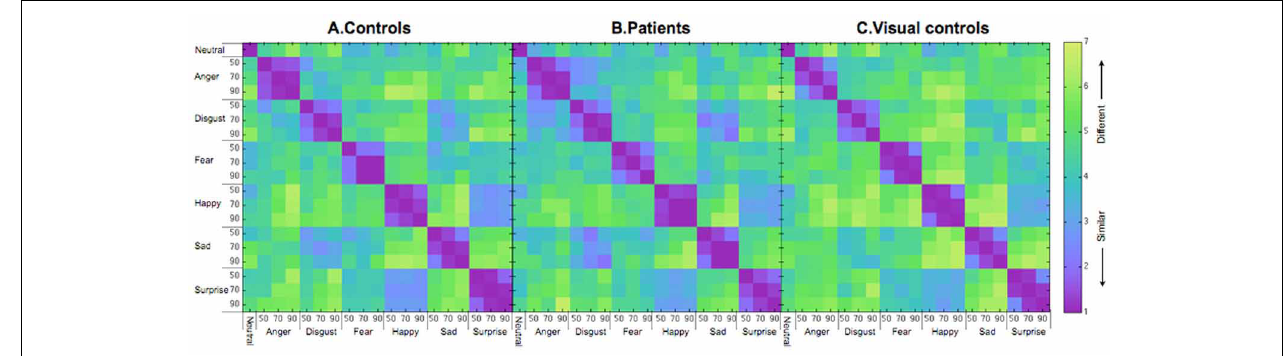
FIGURE 2 | Similarity matrices for (A) controls, (B) patients treated for congenital bilateral cataracts, and (C) visual controls. The numbers on the axes represent intensity levels (%). The similarity scores go from 1 (most similar) to 7 (most different).